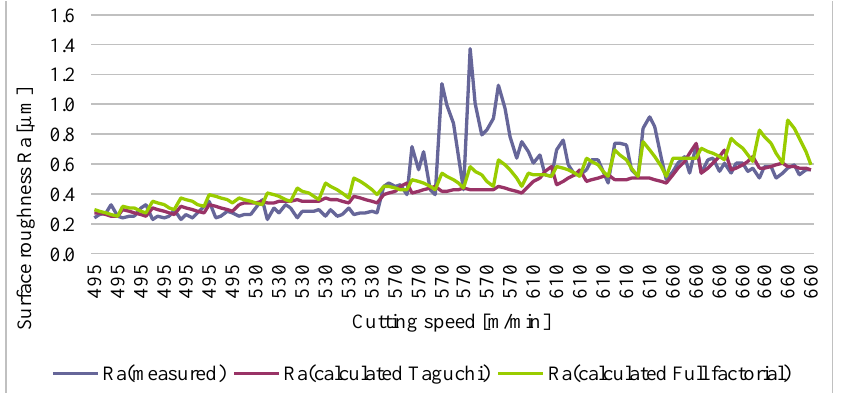
Figure 9. Comparison between the R a measured versus R a calculated using Taguchi′s method and central composite design.